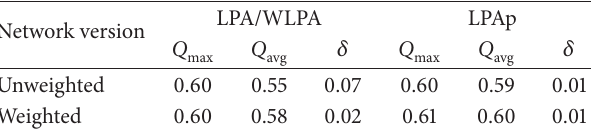
Table 5: Comparisons between LPA, WLPA, and LPAp on unweighted and weighted football network.